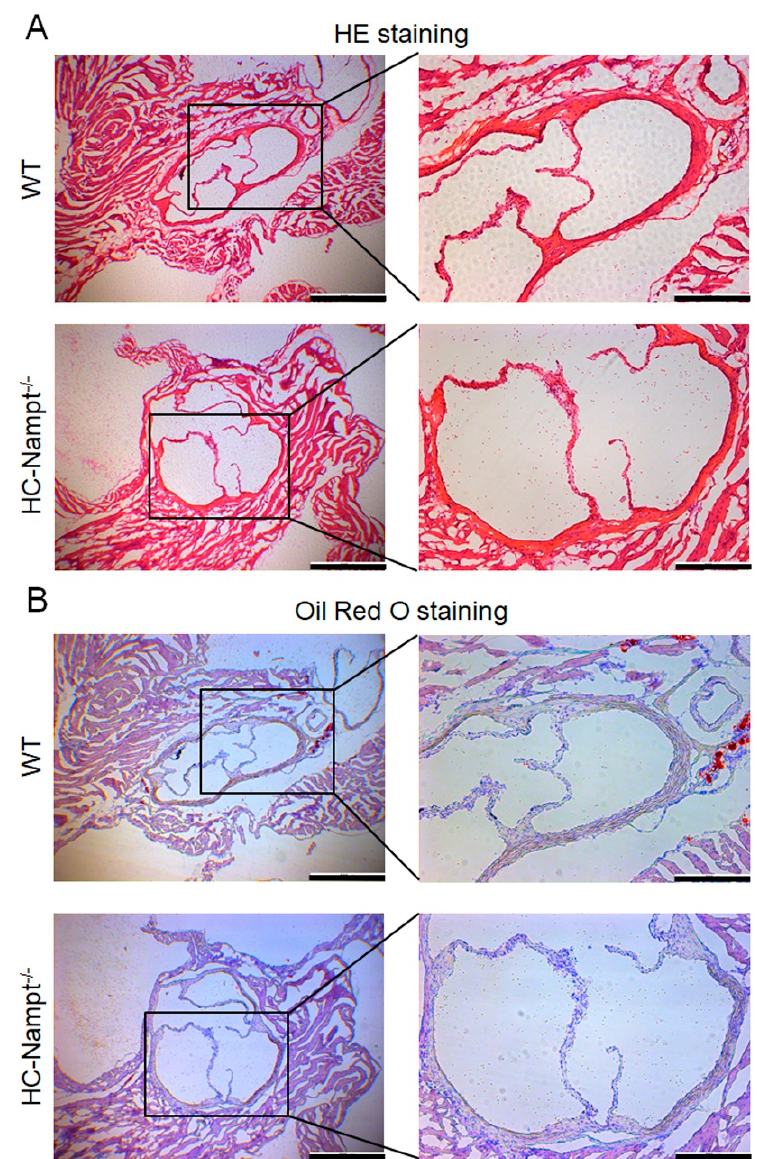
Figure 7. The effect of hepatic Nampt deficiency on aortic root morphology in mice fed a HFD. ( A ) Representative image of HE staining on the aortic root of HC-Nampt -/- and WT mice after 10 weeks of HFD. Global structure shows in the left part, and the scale bar is 500 µ m. Local structure shows in the right part, and the scale bar is 200 µ m. ( B ) Representative image of oil red O staining on the aortic root of HC-Nampt -/- and WT mice after 10 weeks of HFD. Global structure shows in the left part, and the scale bar is 500 µ m. Local structure shows in the right part, and the scale bar is 200 μ m.